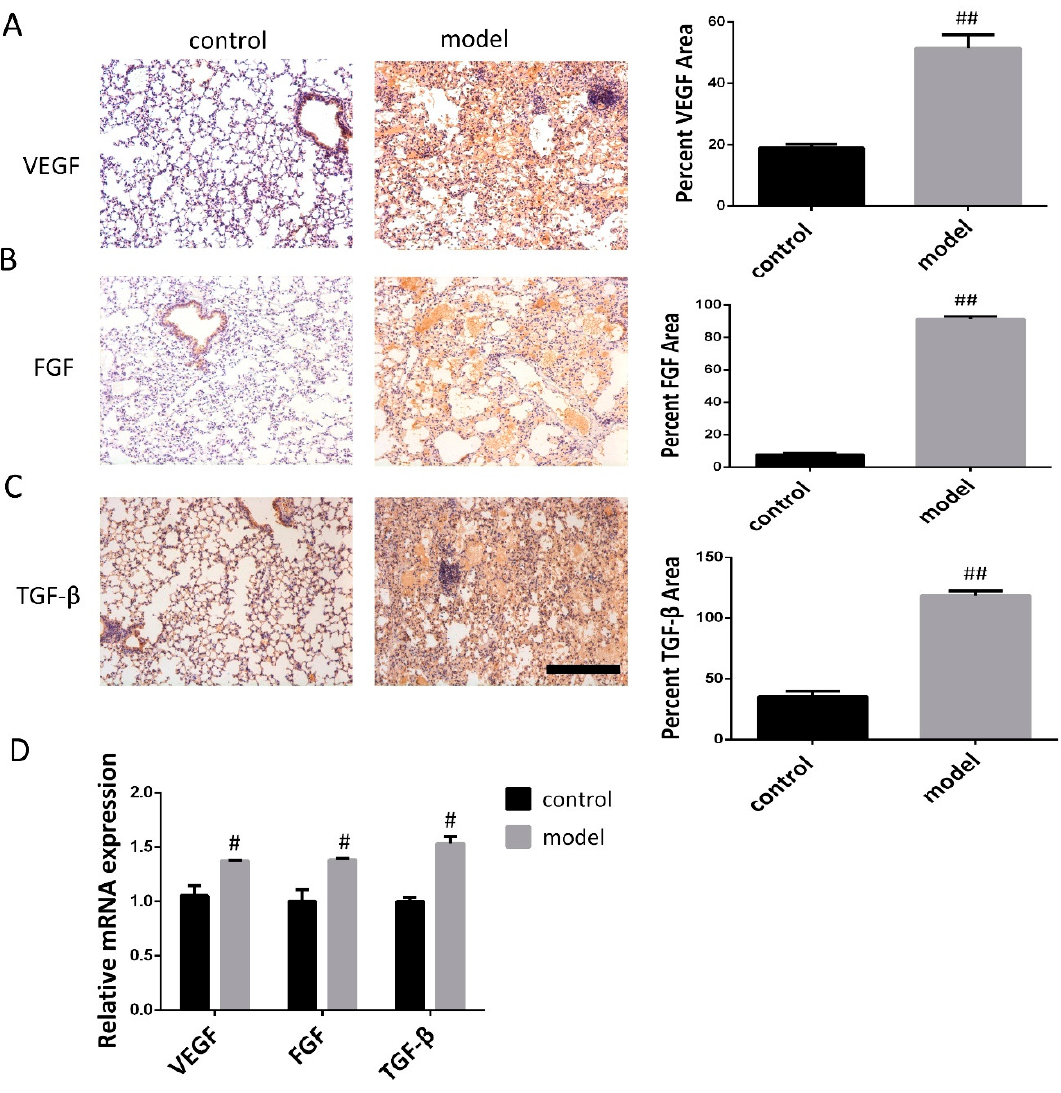
Figure 3. Expression levels of VEGF, FGF, and TGF- β in lung of mice after bleomycin-induced pulmonary fibrosis formation. ( A – C ) The VEGF, FGF, and TGF- β expression levels in the control mice and modeling mice were determined by immunohistochemistry assay. Scale bar = 200 µ m for each picture (original magnification: X100, n = 4 per group). Quantitative analysis of VEGF, FGF, and TGF- β positive area. Densitometry data are shown as mean ± SD. ( D ) The levels of VEGF, FGF, and TGF- β mRNA in lung tissue were detected by qRT-PCR (n = 6 per group). Results are shown as mean ± SD. # p < 0.05, ## p < 0.01 versus control.